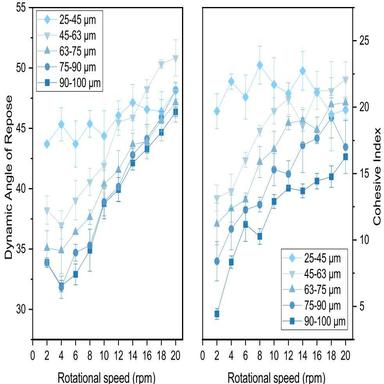
Overview of the dynamic Angle of Repose (a, left) and the Cohesive Index (b, right) plotted as a function of the rotational velocity, measured by the rotating drum method.